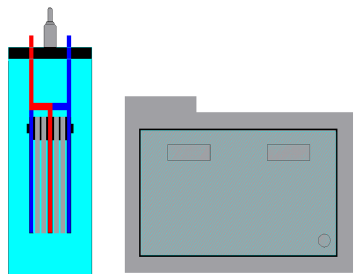
Figure 2. Wet cell diagram on the left, dry cell diagram on the right (Own study).